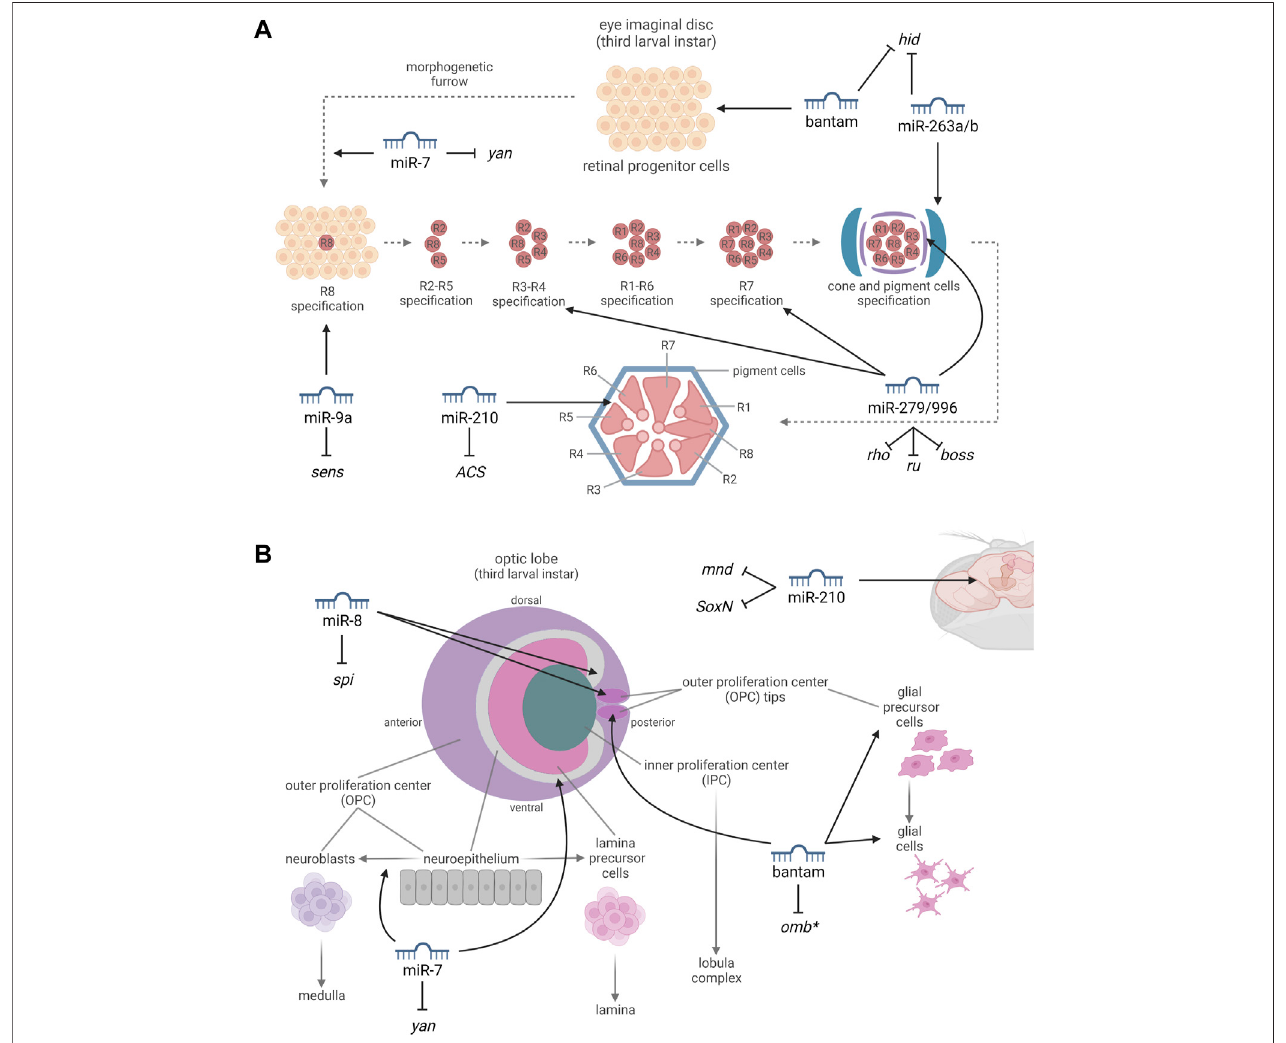
FIGURE 2 | miRNAs involved in the development and in the proper functioning of the compound eye (A) and optic lobe (B). (A) By targeting the proapoptotic gene hid , bantam promotes cell proliferation and survival in the progenitor cells of the eye imaginal disc. miR-7, targeting yan , promotes a photoreceptor cell fate. miR-9a, targeting sens , is thought to be involved in the differentiation of the R8 photoreceptor, which occurs by a neuronal selection process such as is observed in the sensory organ precursor cells (SOPs). miR-279/996, targeting rho , ru , and boss , are required for the de fi nition of ommatidial cell fates. miR-263a/b, targeting hid , protect thedevelopingsenseorgansandinterommatidialcells(IOCs),fromapoptosis.miR-210,targeting ACS ,isessentialtopreventprogressiveretinaldegeneration. (B) miR- 7, targeting yan ,buffers thetransition fromneuroepithelialcellstoneuroblasts.miR-8,expressed intheoptic-lobe-associated cortex gliaand targeting thegrowth factor spi , promotes the increase of glial size and is required to limit the growth and neuroblast formation within the neuroepithelium. By leading to the downregulation of omb , bantamisimportantforstemcellmaintenanceandforglialcellgrowth.miR-210,targeting mnd and SoxN ,affectsneurogenesis.*miRNA-mRNAinteractionswhichhave not been experimentally con fi rmed yet. Created with